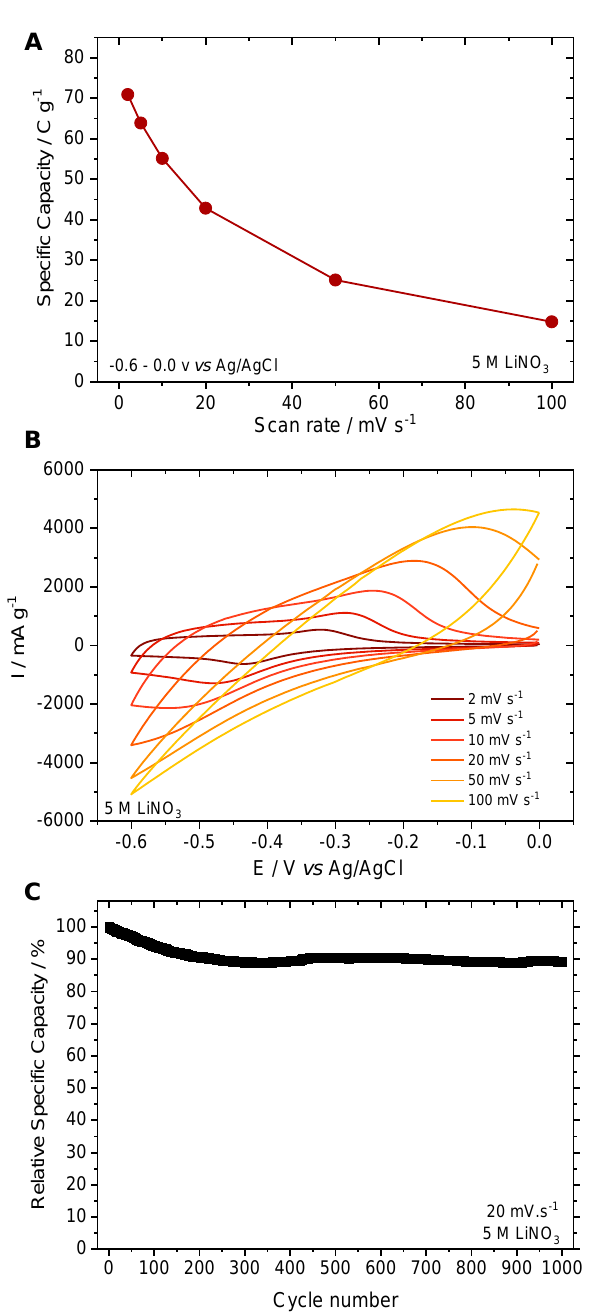
Figure 3. ( A ) Evolution of the capacity in C.g − 1 vs. the scan rate, ( B ) cyclic voltammograms of the respective scan rates, and ( C ) relative specific capacity vs. cycle number. Fluctuations after 400 cycles may be due to slight changes in electrolyte temperature while cycling the electrode. Li-HTB is capable of accommodating more Li + than what is reported here, as previous studies have shown with a similar hexagonal structure although using an organic electro- lyte. However, to preserve the structure ’ s stability, a maximum of 0.33 cations can be in- tercalated [46,47]. Aside from this, it is worth noting that the water occupying the hexag- onal cavity between two layers of hexagonal rings (as reported in the structural refinement